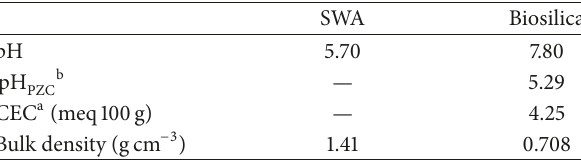
Table 3: Physical-chemical properties of biomass ash and biosilica.